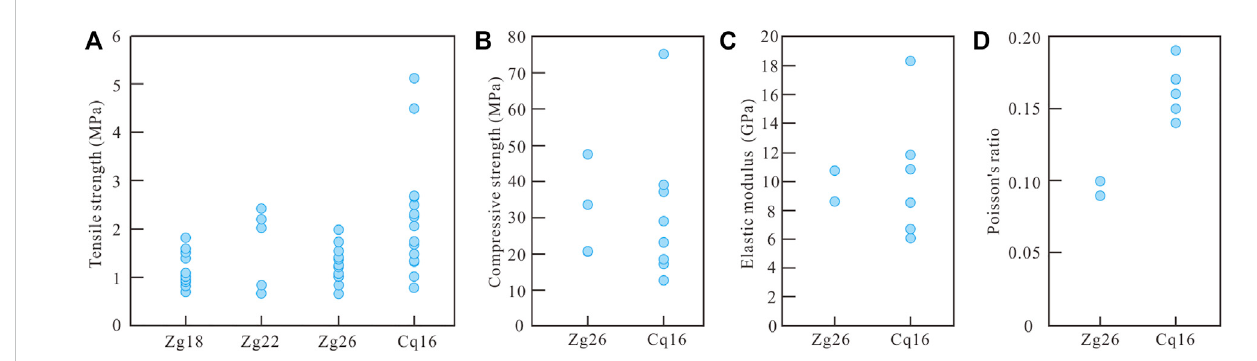
FIGURE 6 Mechanical parameters of shale rock in the Taiyuan Formation of Wells Zg18, Zg22, Zg26 and Cq16, including tensile strength (A) , compressive strength (B) , elastic modulus (C) and Poisson ’ s ratio (D)